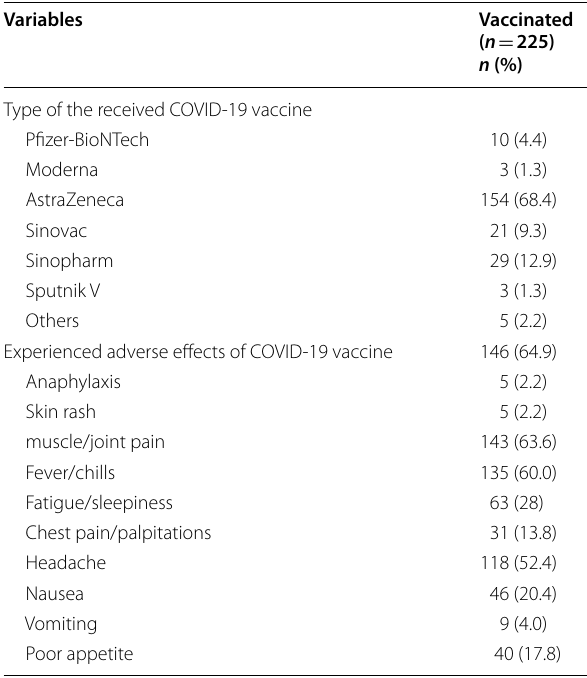
Table 4 Types of the received COVID-19 vaccine and the experienced adverse effects in the university students